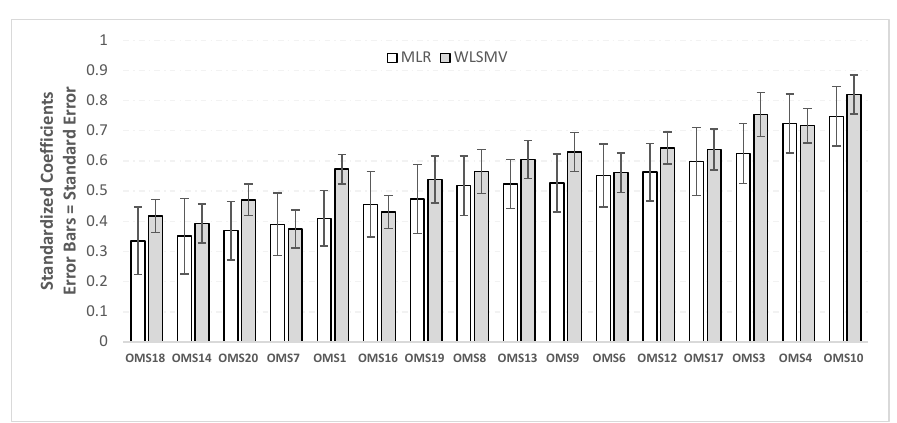
Figure A1. Comparison of estimates of Confirmatory Factor Analysis between methods MLR (Robust Maximum Likelihood) and WLSMV (Weighted Least Square with Mean and Variance adjusted chi-square).